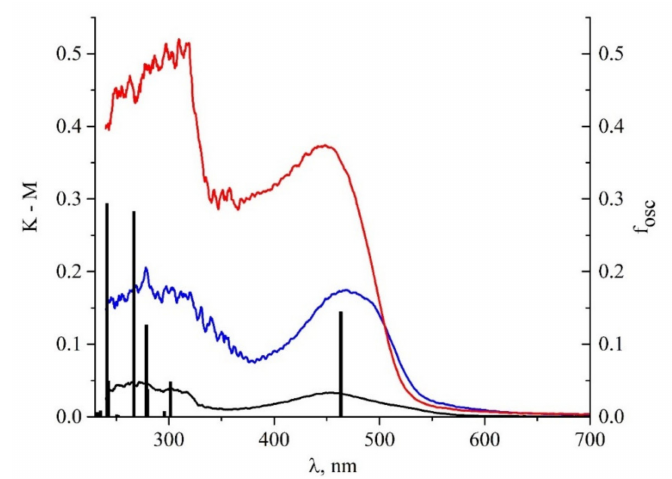
Figure 4. UV-Vis spectra of the solid samples of 1 (black) [19], 2 (red), and 3 · 2C 7 H 8 (blue) mixed with BaSO 4 , presented in the form of Kubelka–Munk (K–M) functions; the intensities are recalculated to 0.005 mole fraction of the compounds. Black vertical lines represent calculated TD-DFT transitions (ZORA-PBE0/def2-TZVP(-f)) for 1 .